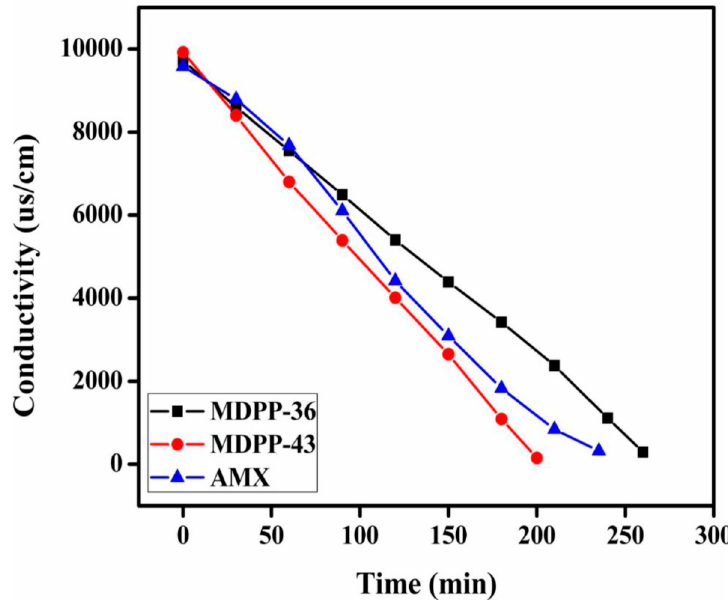
Figure 6. The change in conductivity in dilute cell during ED tests.